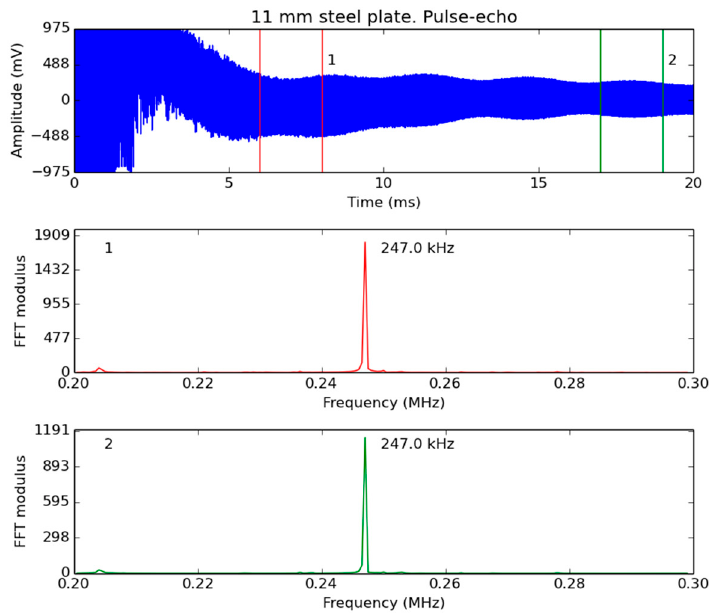
Figure 8. Pulse-echo; 11 mm-thick stainless steel plate. Top: signal in the time domain. Center: FFT modulus of the signal within window (1). Bottom: FFT modulus of the signal within window (2).